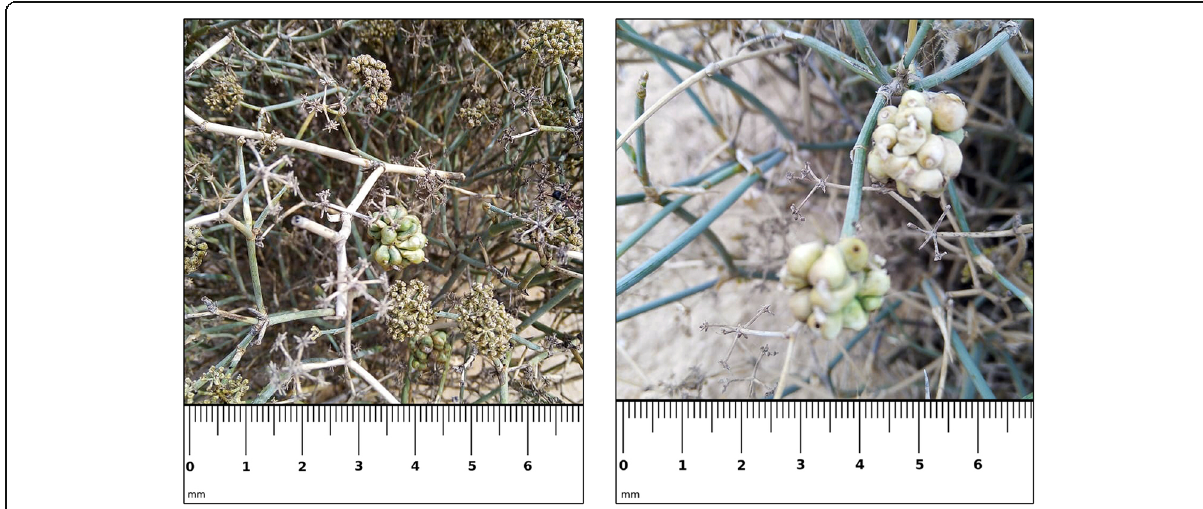
Fig. 2 The berry-like galls of Schizomyia buboniae (1.5 – 2.5 mm)